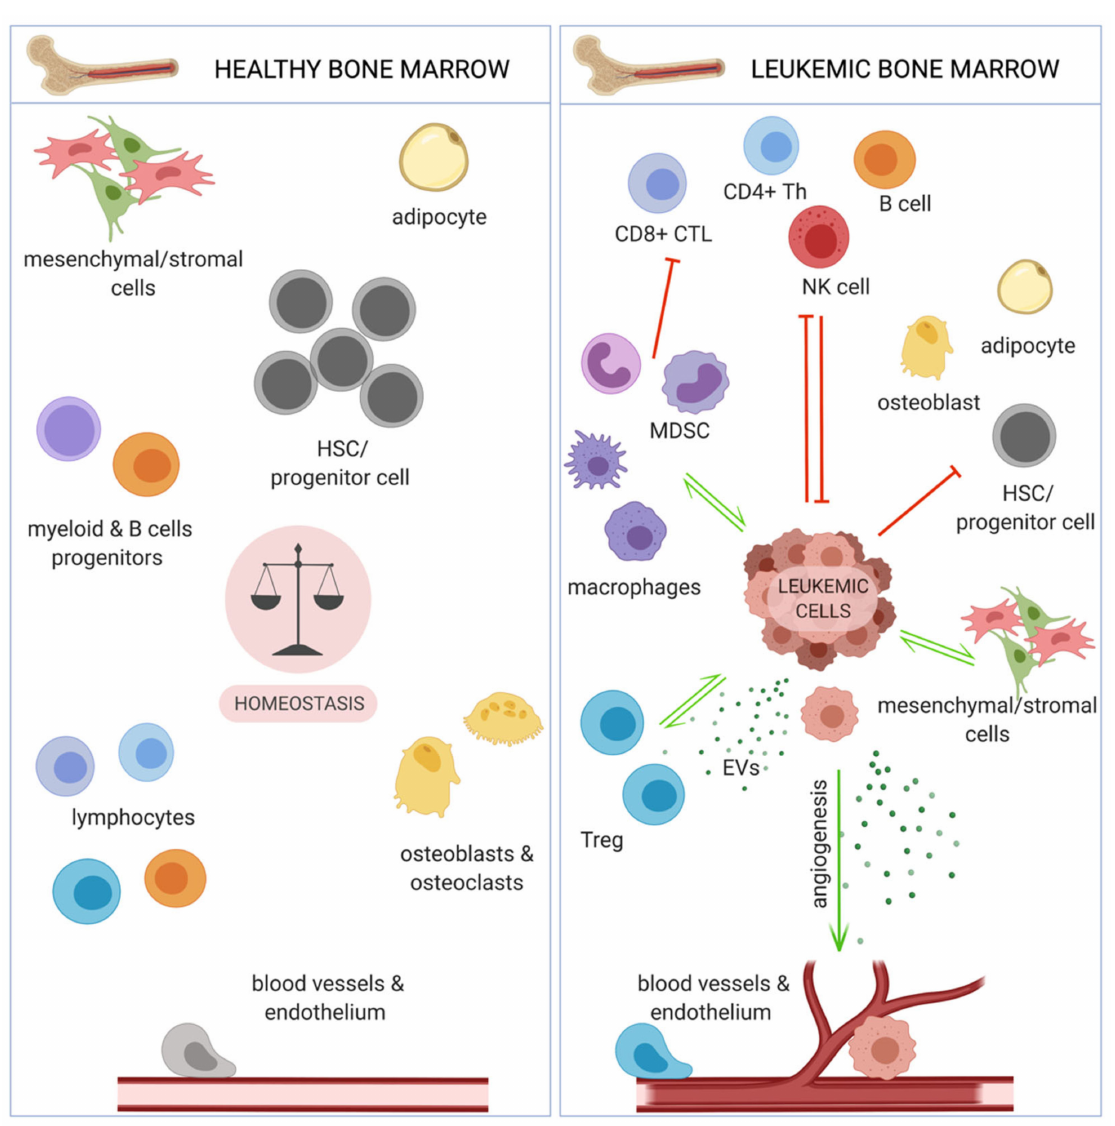
Figure 2. Bone marrow microenvironment in steady state and myeloid leukemias. While healthy bone marrow is char- acterized by well-balanced homeostasis (left panel), leukemic bone marrow is out of balance (right panel). Several cell types and processes that facilitate leukemia development are strongly promoted (green arrows), and some physiological processes, including normal hematopoiesis and immune response, are inhibited (red arrows). HSC–hematopoietic stem cell; CTL–cytotoxic T lymphocyte; NK–natural killer; MDSC–myeloid derived suppressor cell; Treg–regulatory T cell; EVs–extracellular